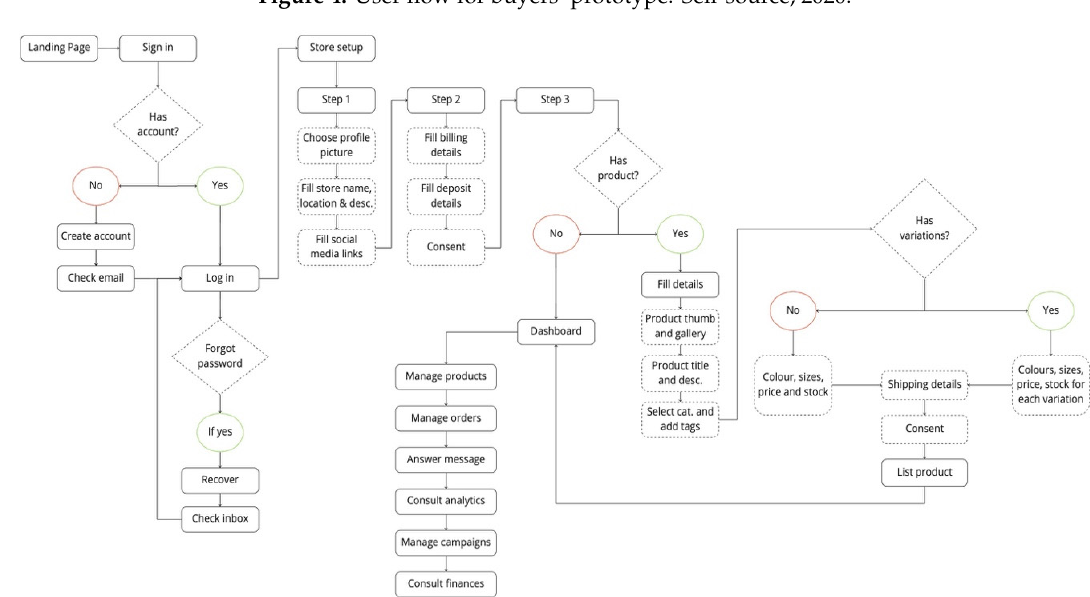
Figure 5. Seller user flow. Self-source, 2020.